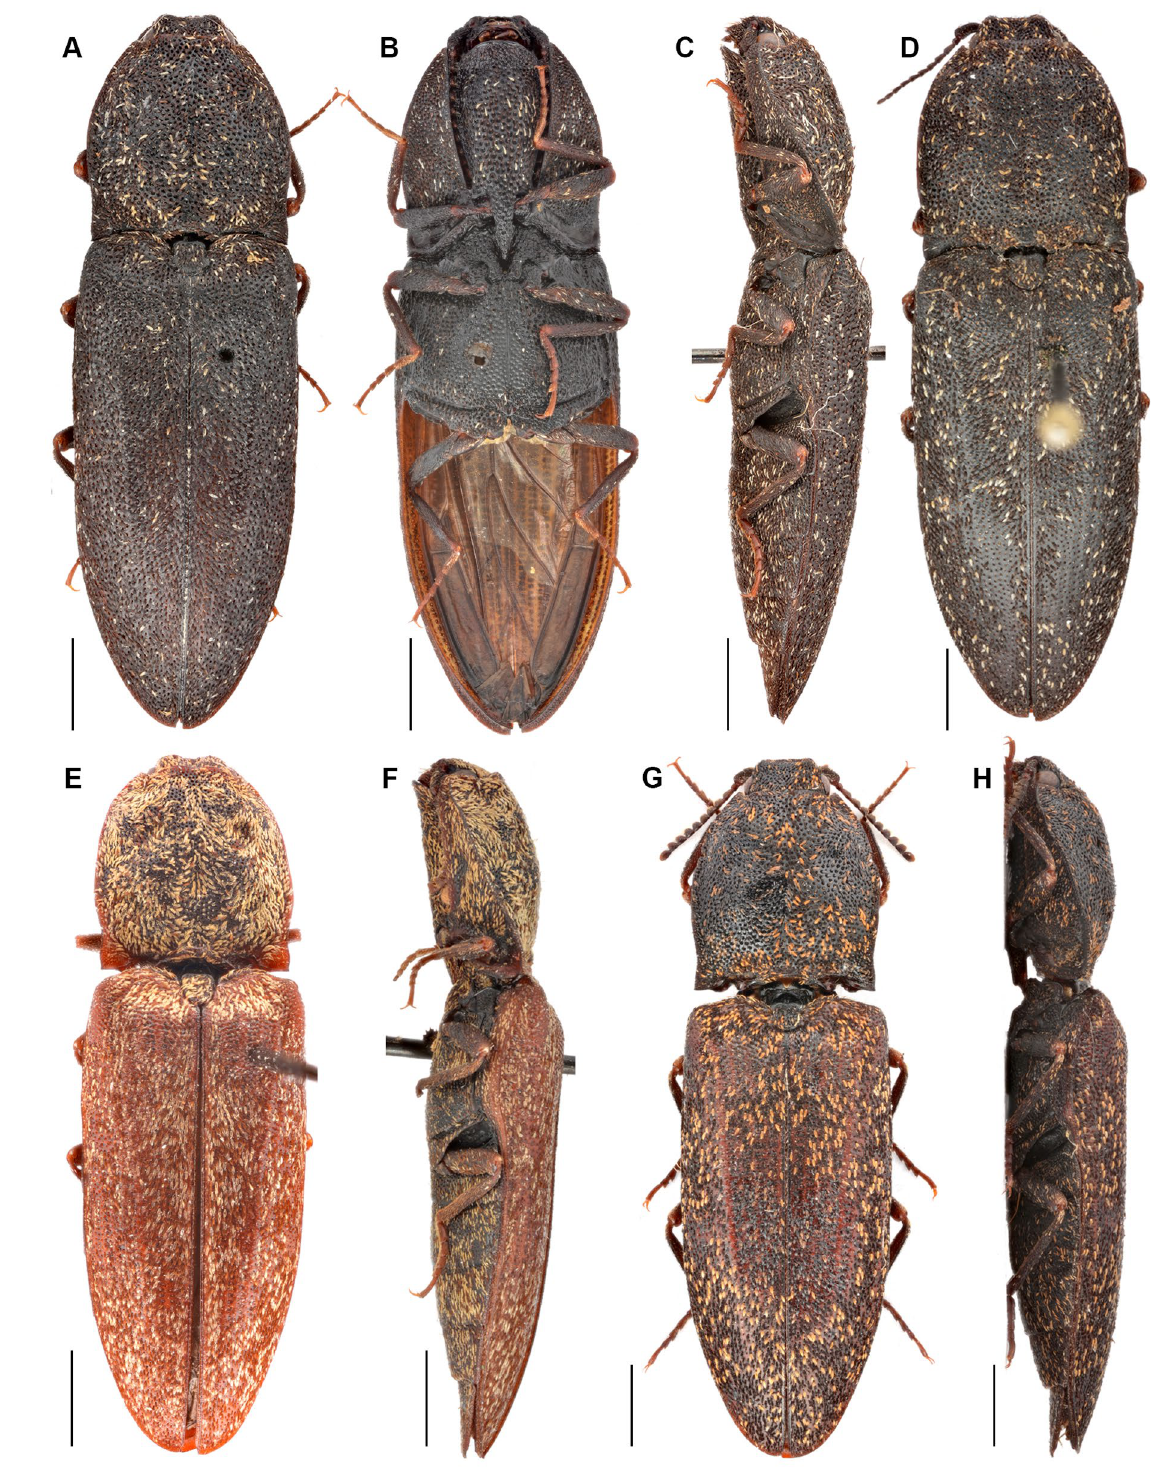
Fig. 1. habitus images of Lacon spp. A–C . L. mertliki sp. nov, holotype, ♂, in dorsal, ventral and lateral view, respectively. D . L. mertliki sp. nov, paratype, ♀, dorsal view. E–F . L. lepidopterus (Panzer, 1801), ♂ (lectotype of L. aurosquamosus (Jagemann, 1944)) in dorsal and lateral view, respectively. G–H . L. lepidopterus , ♀ from Turkey in dorsal and lateral view, respectively. Scale bars = 2.0